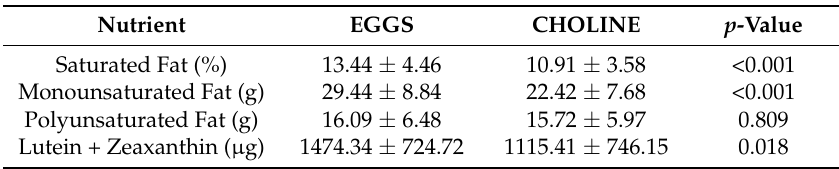
Table 3. Dietary records for fats and carotenoids of healthy, young population ( n = 29) at the end of each intervention arm, eggs versus choline supplement intake for 4 weeks